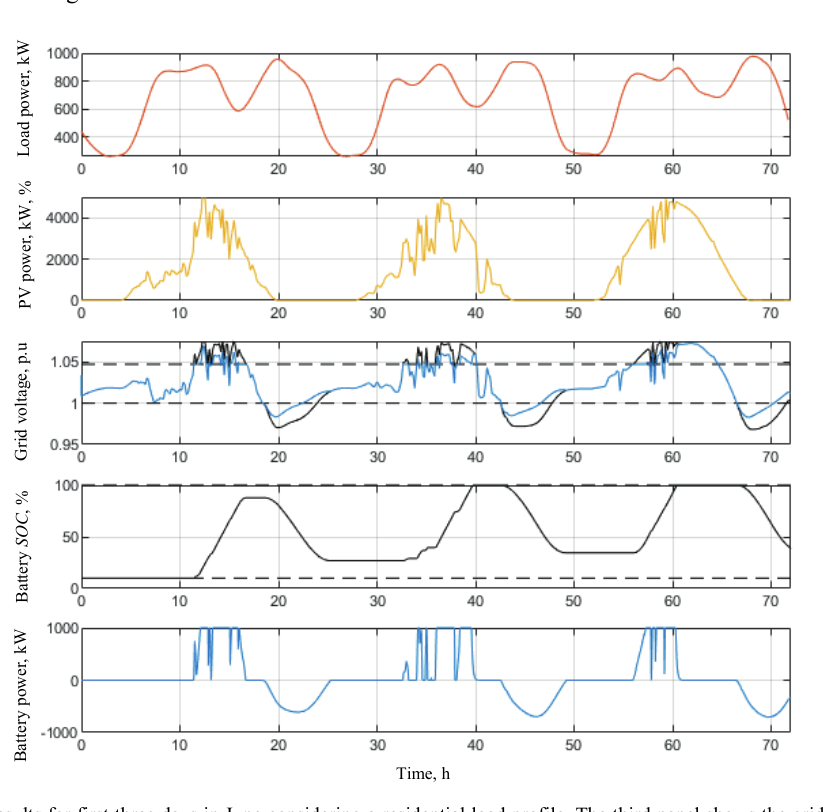
Fig. 4. Results for first three days in June considering a residential load profile. The third panel shows the grid voltage: black line – without battery, blue line – with 5 MWh battery storage. Dashed lines indicate the limits for charging and discharging of the